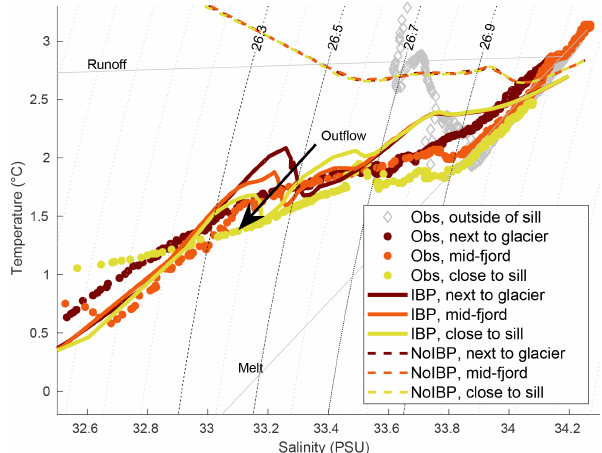
Figure 7. August potential temperature versus salinity next to the glacier (brown), mid-fjord (orange) and close to the sill (yellow), for observations (circles) (Beaird et al., 2017), IBP (solid lines) and NoIBP (dashed lines), with runoff and melt lines (grey lines) and isopycnals (dotted grey lines). Dotted grey contours indicate isopy- cnals at 0.1kgm − 1 intervals, with 26.3, 26.5, 26.7 and 26.9kgm − 1 indicated in black (also plotted in Fig.